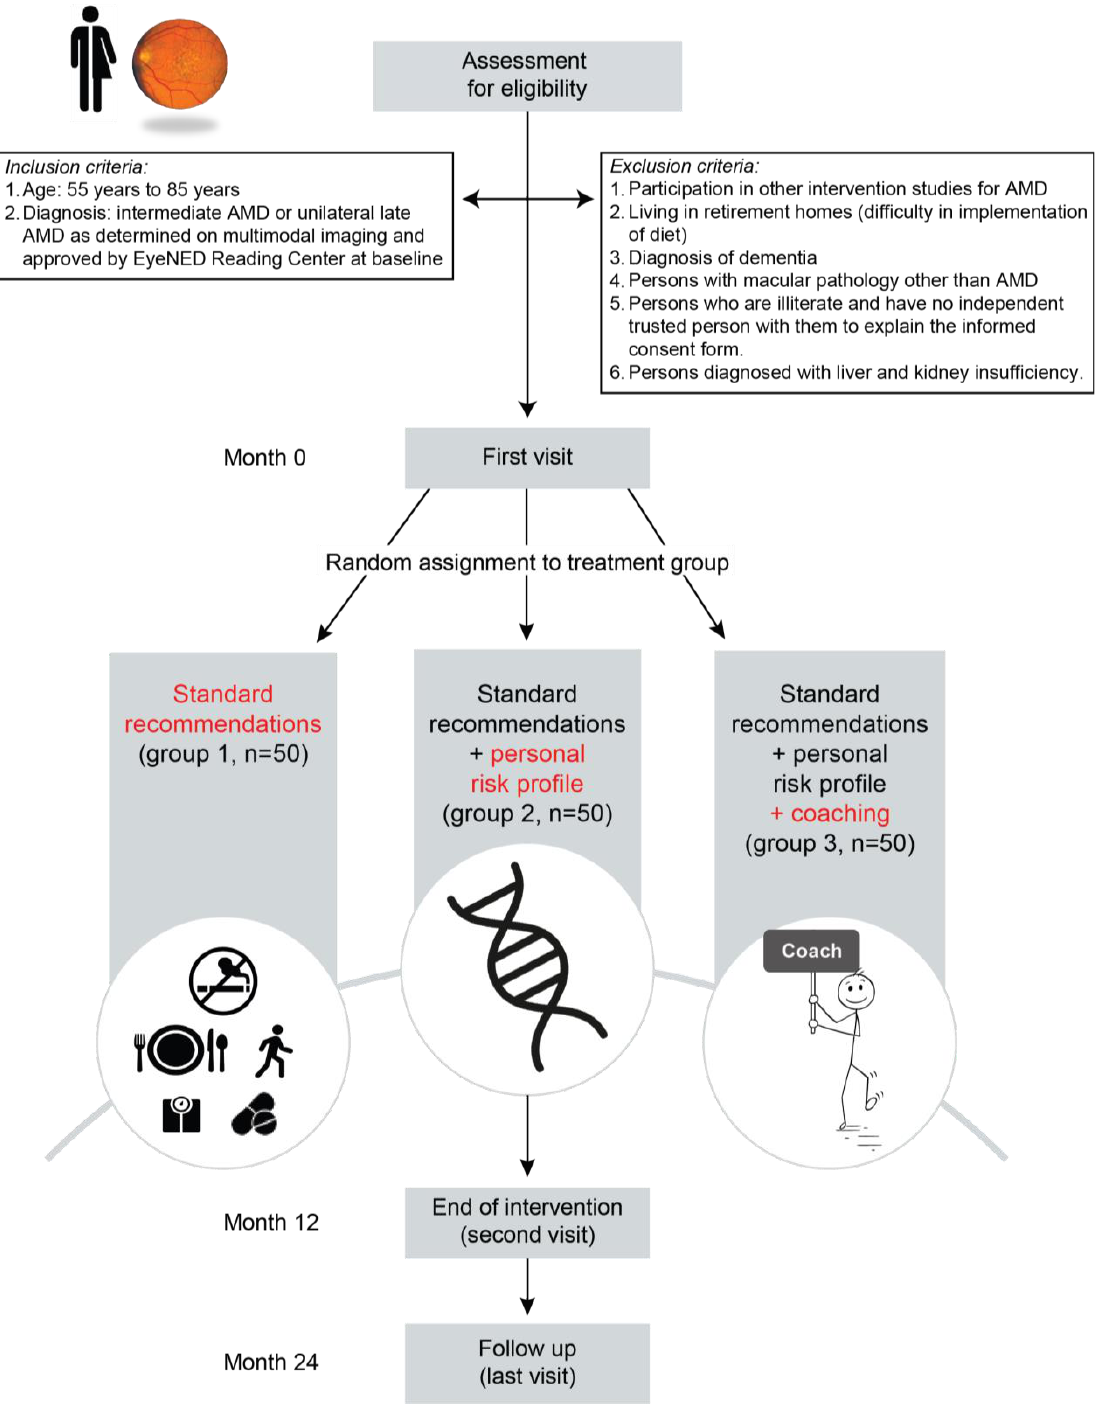
Figure 1. Flow-chart of the AMD-Life study design. Inclusion and follow-up of study